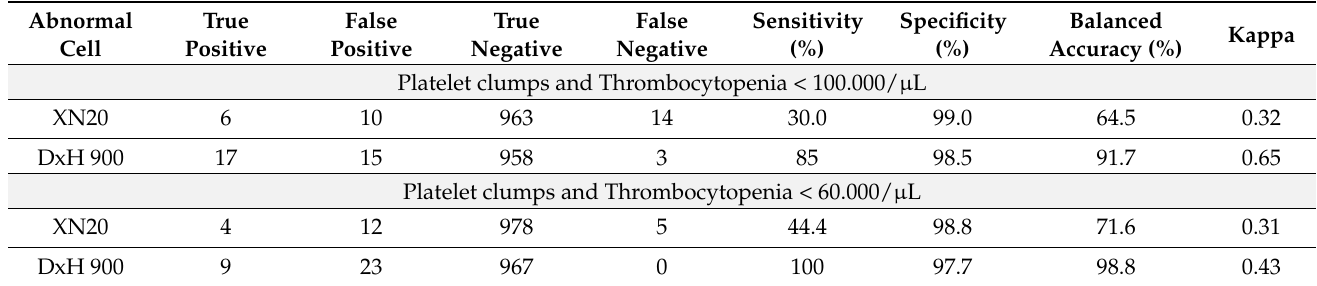
Table 9. Platelet clumps flag sensitivity and specificity in the DxH 900 and the XN20 combined with thrombocytopenia (<100,000/ µ L and <60,000/ µ